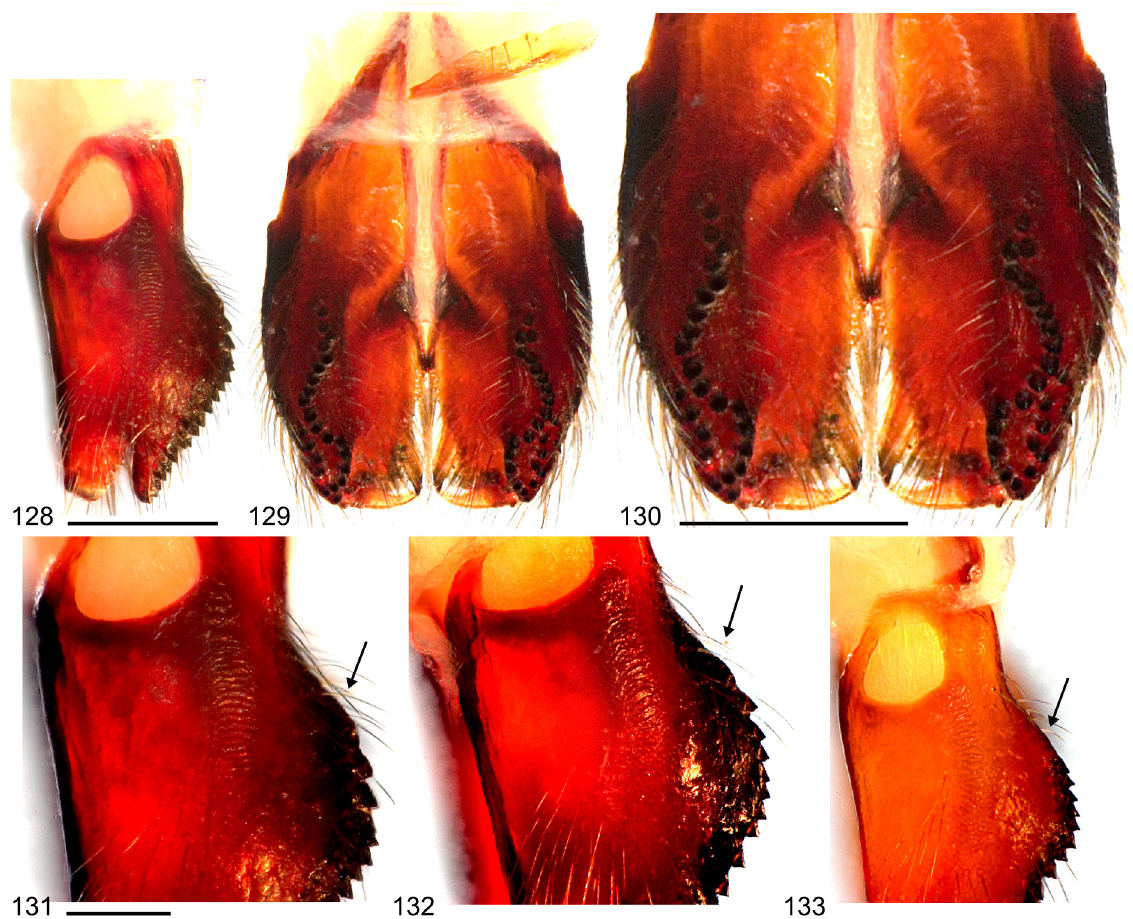
Figs 128–133. Artema transcaspica Spassky, 1934, male chelicerae in lateral and frontal views. 128– 131 . ♂♂, Uzbekistan, Zarafshon (ZMMU). 132 . ♂, Turkmenistan, Badkhyz, Kushka (NHMW 13.677). 133 . ♂, Uzbekistan, 36.5 km SSW of Uchkuduk (ZMMU). Arrows = absence of proximal projections on frontal processes. Scale lines: 128–130 = 0.5 mm; 131–133 =